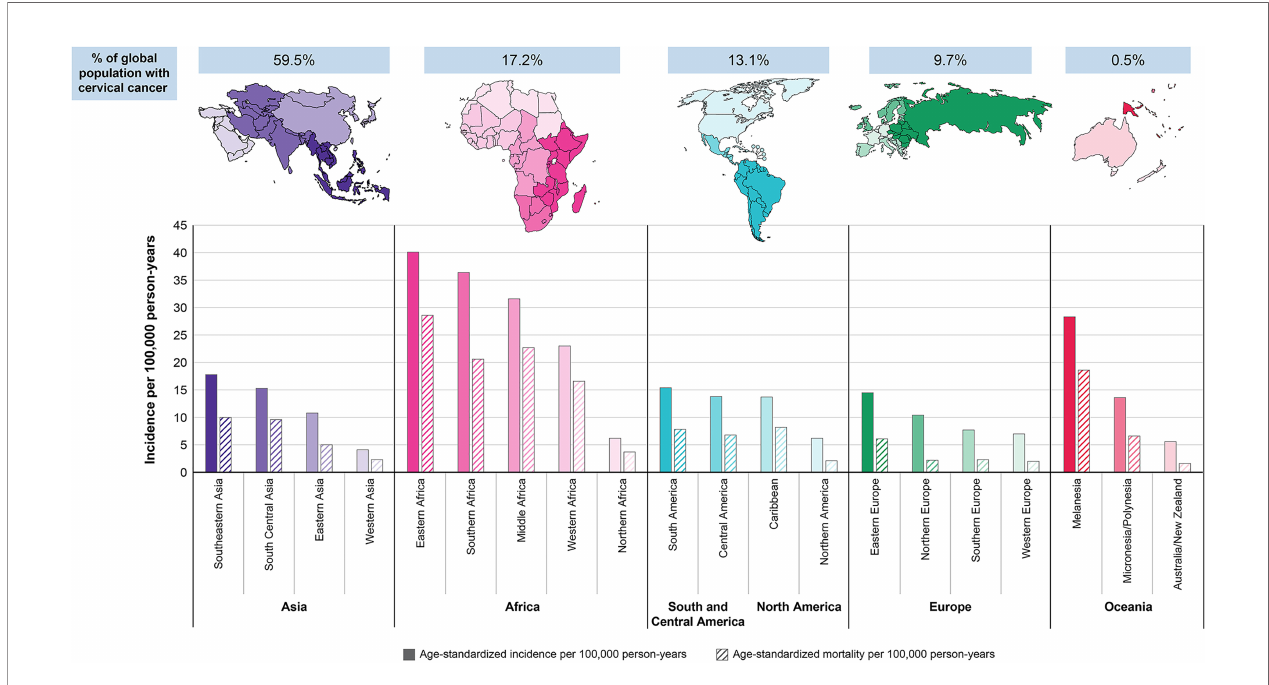
FIGURE 1 | Region-speci fi c age-standardized incidence and mortality rates for cervical cancer in 2020